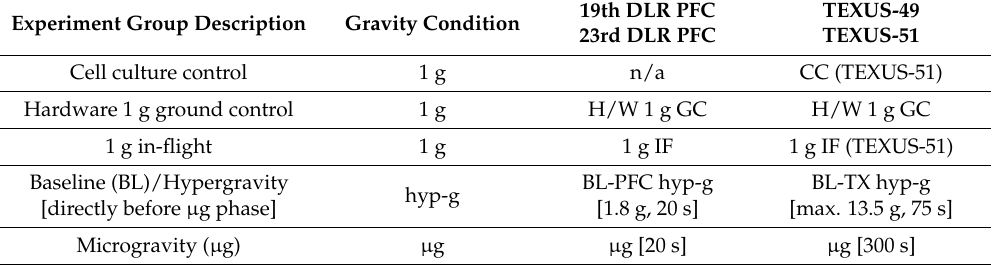
Table 1. Experiment group description of the parabolic flight campaigns (PFC) (19th and 23rd German Aerospace Center (DLR)) and the sounding rocket campaigns (Technologische Experimente unter Schwerelosigkeit (TEXUS) TEXUS-49 and TEXUS-51). Maximum g-level and altered gravity times are given in brackets. BL = Baseline, hyp-g = hypergravity, µ g = microgravity, IF = in flight, H/W= hardware, TX =